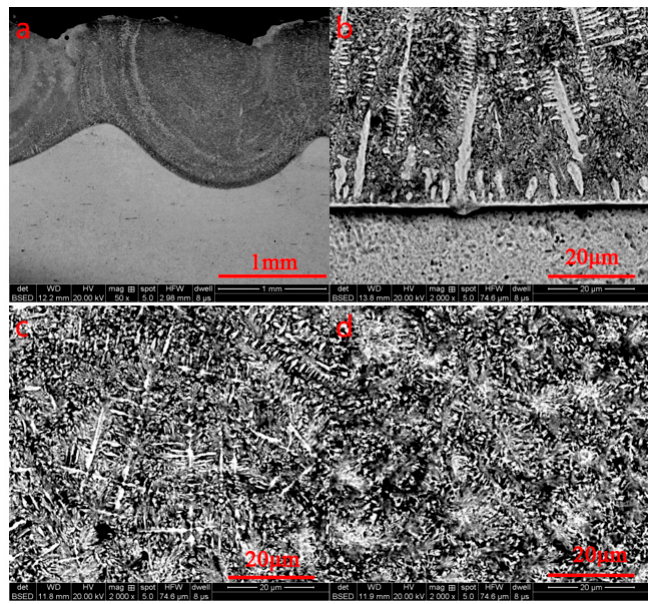
Figure 11. SEM micrographs of the inside of the cladding layer. ( a ) The overall picture of the cladding layer. ( b ) The lower, ( c ) middle, and ( d ) upper parts of the cladding layer.